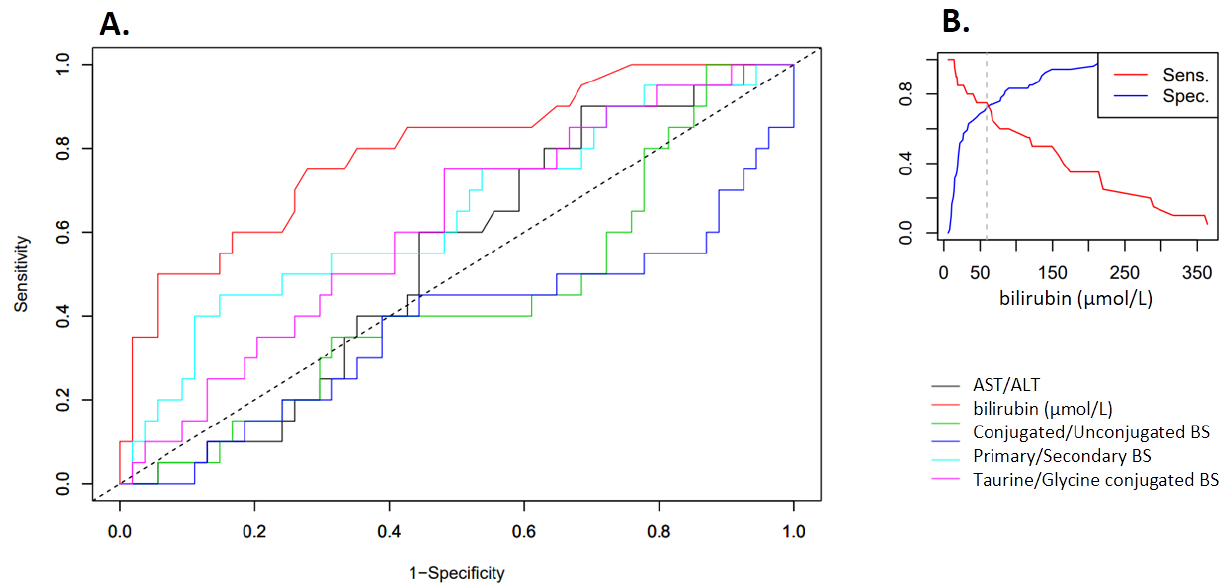
Figure 6. ( A ). ROC curves for the determination of diagnostic values of various markers to discriminate neoplasms (pancreatic cancer or cholangiocarcinoma) vs. nonmalignant changes (stricture and choledocholithiasis). Only bilirubin (AUC 0.793 with a p < 0.001). was statistically significant ( B ). Sensitivity and Specificity curve for bilirubin concentration clearly indicates a specificity of close to 77% if serum level is over 55 µ